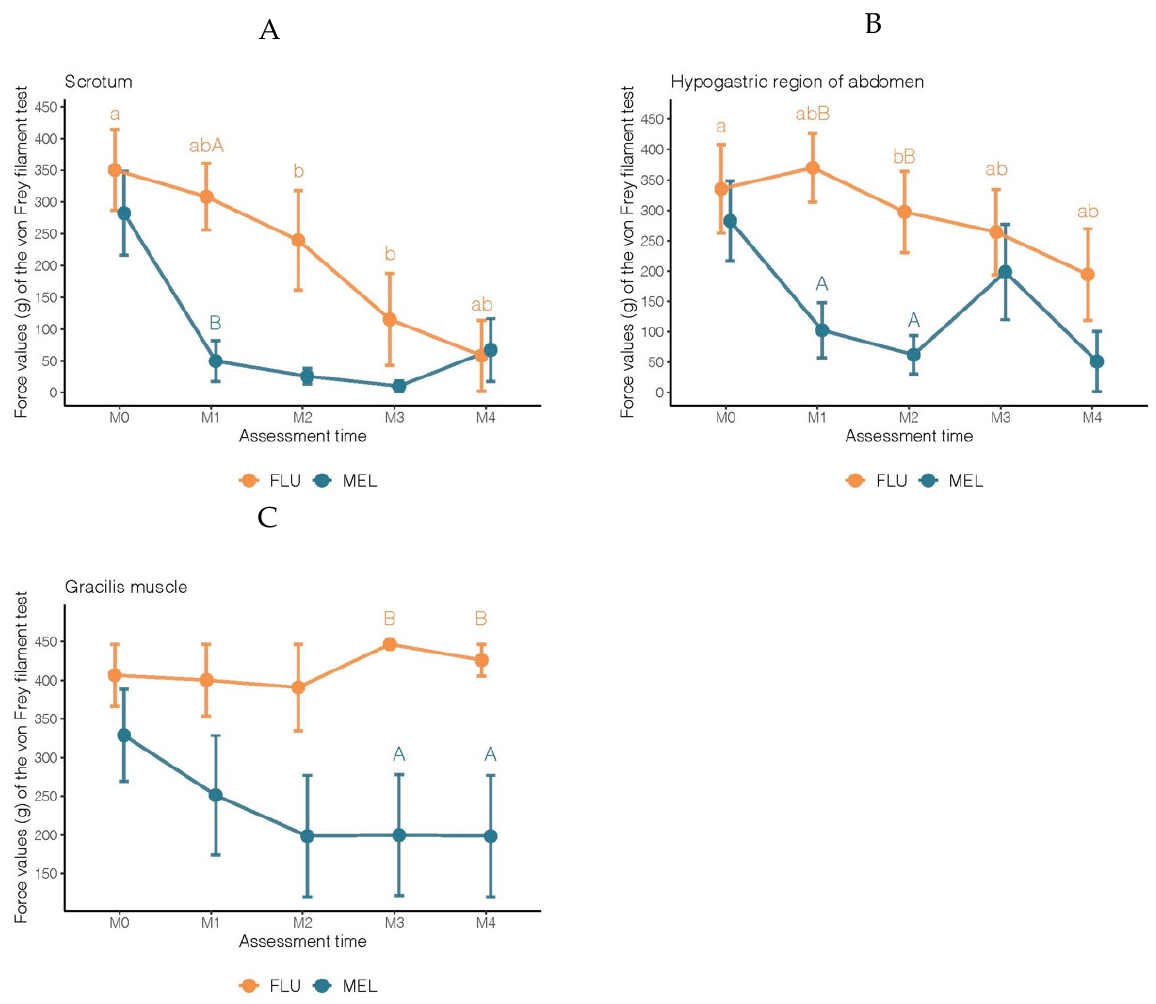
Figure 2. Mean force values (g) ± standard deviation of the von Frey filament test obtained in goat kids subjected to a surgical castration procedure under anesthesia and receiving analgesic protocols with meloxicam (MEL: 0.5 mg/kg − 1 IM) or flunixin meglumine (FLU: 1.1 mg/kg − 1 IM). Assessments were performed just before castration (M0), just after castration (M1), 1, 2, or 3 days after castration (M2, M3, and M4, respectively), in three body regions: ( A ) scrotum (average of four points), ( B ) hypogastric region of the abdomen, and ( C ) gracilis muscle. Notes: Lowercase letters indicate significant differences over time (M0 vs. M1 vs. M2 vs. M3 vs. M4) within the same treatment group (FLU and MEL) and each body region (A: Scrotum, B: Hypogastric region of abdomen, and C: Gracilis muscle). Capital letters represent significant differences between treatments (MEL vs. FLU) within each body region.